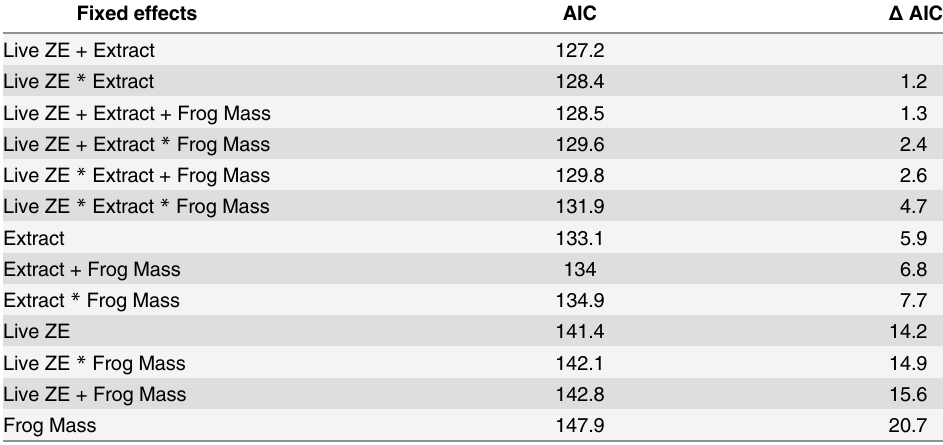
Table 2. Results of generalized linear models of post-preservation Bd detection success. All models included a random effect of individual frogs. The top three models included extract (PM and MN), pre-preser- vation Bd load (Live ZE), and individual frog